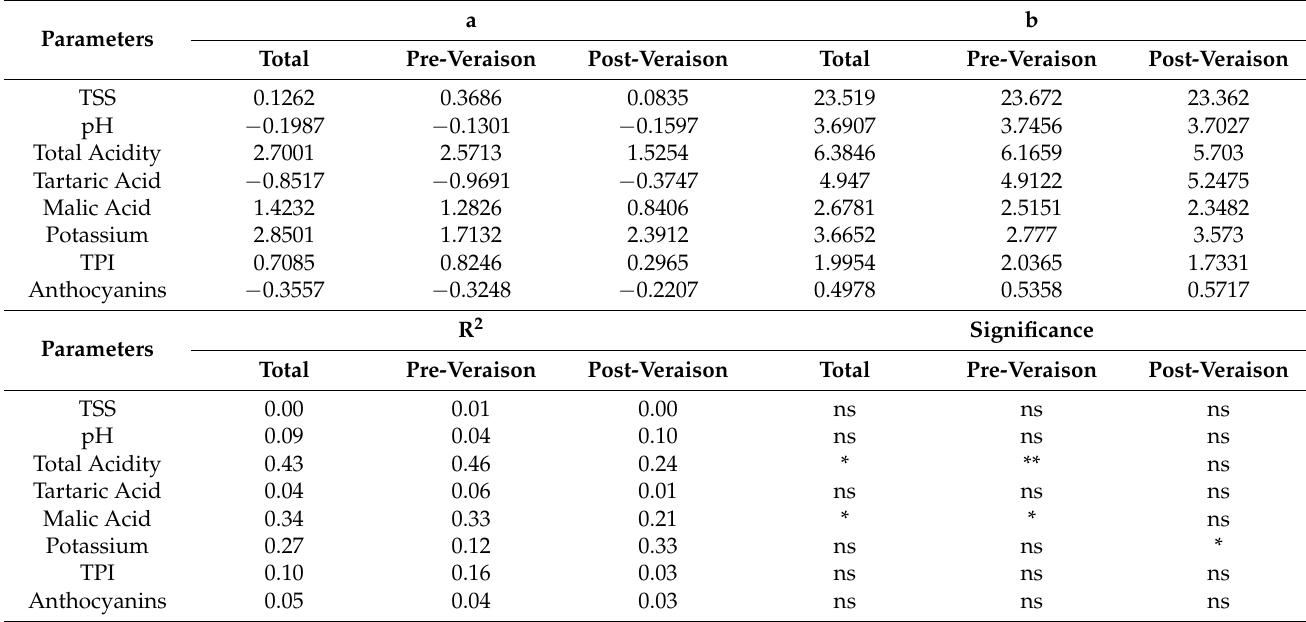
Table 9. Relationships between annual water status (Total), in pre-veraison and post-veraison, of the high load treatments, and quality parameters, using a linear function.